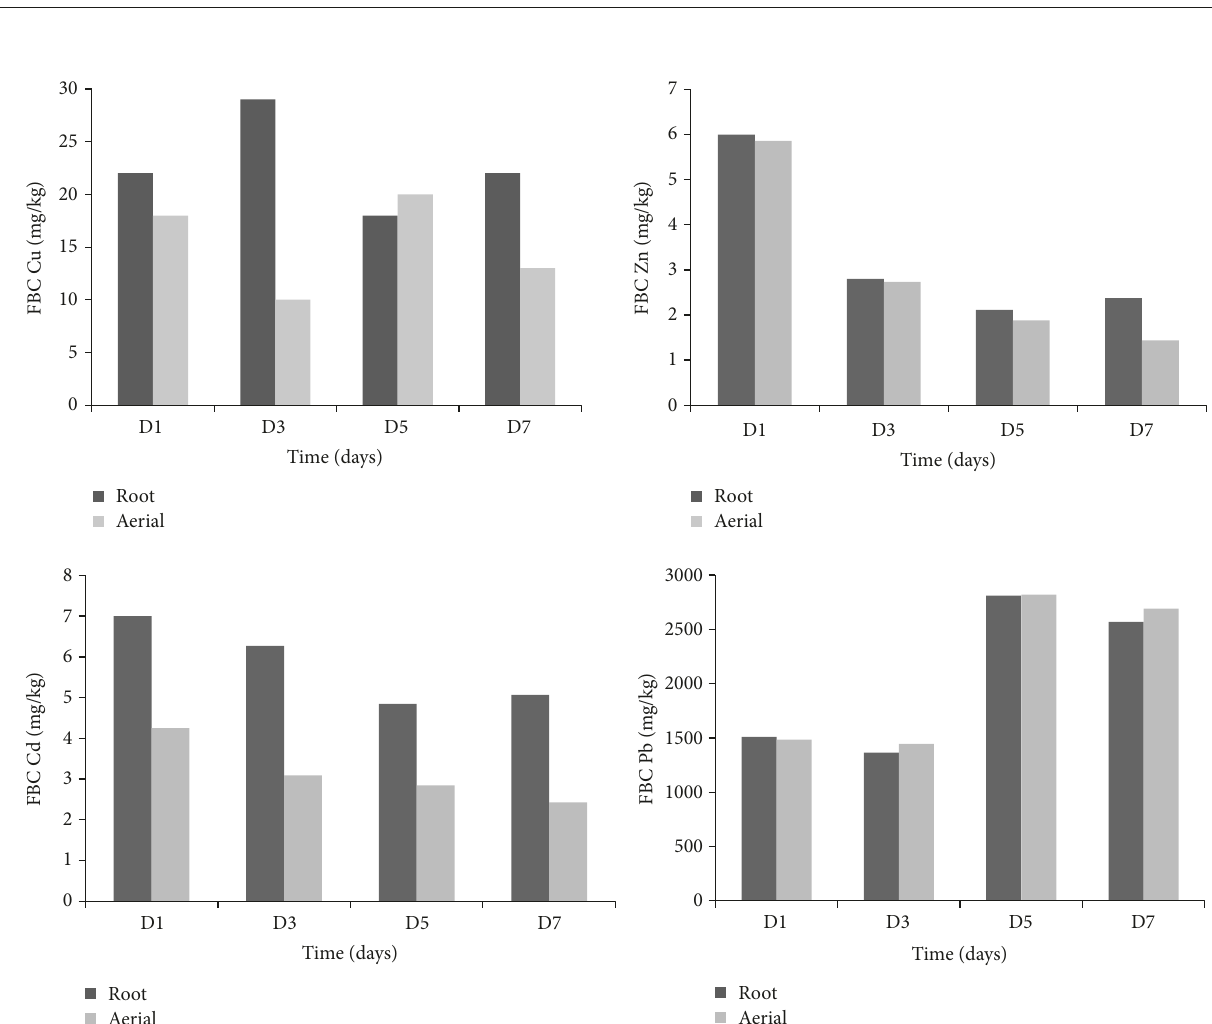
Figure 8: Bioaccumulation factor of Cu, Zn, Pb, and Cd in leaf and root of Typha latifolia L., during 7 days of treatment